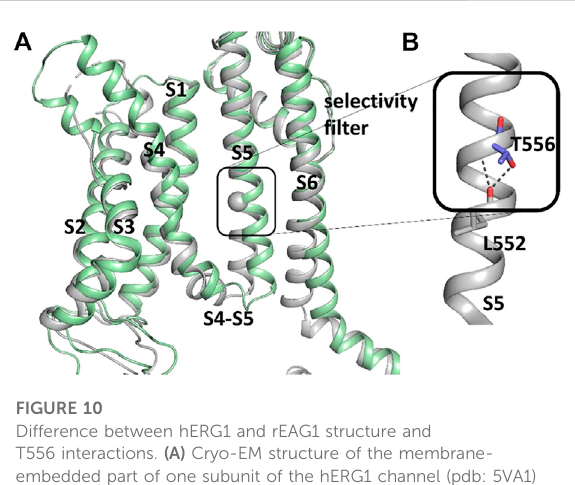
FIGURE 10 Difference between hERG1 and rEAG1 structure and T556 interactions. (A) Cryo-EM structure of the membrane- embedded part of one subunit of the hERG1 channel (pdb: 5VA1) represented in gray and the EAG1 structure (pdb: 5K7L) in green. The c-alpha atom of T556 is represented as sphere. (B) Part of the S5 of the hERG1 channel structure with details of the T556 h-bond formation to the backbone of L552. T556 and L552 are shown as